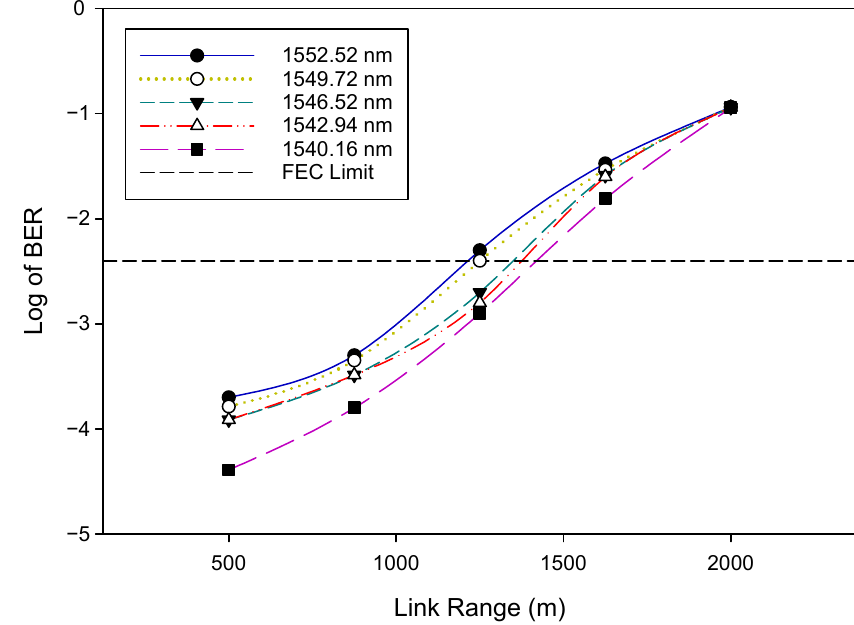
Figure 5. BER versus Link range plots for selected WDM